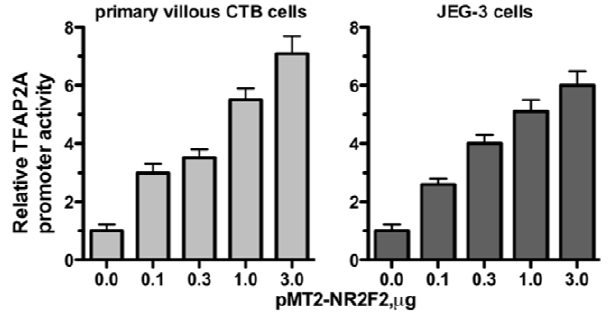
Figure 1. Time course of TFAP2A and NR2F2 mRNA levels during villous CTB differentiation. An enriched fraction of enzymatically dispersed villous CTB cells were cultured in vitro for five days as described in Methods. TFAP2A and NR2F2 mRNA levels were determined by real-time PCR at the end of each day. The amounts of TFAP2A and NR2F2 mRNAs in each culture well were normalized to the amount of GAPDH mRNA in the same sample. Each point represents the mean 6 SEM of triplicate observations from 3 different placenta cell preparations (n=3 wells/placenta culture).